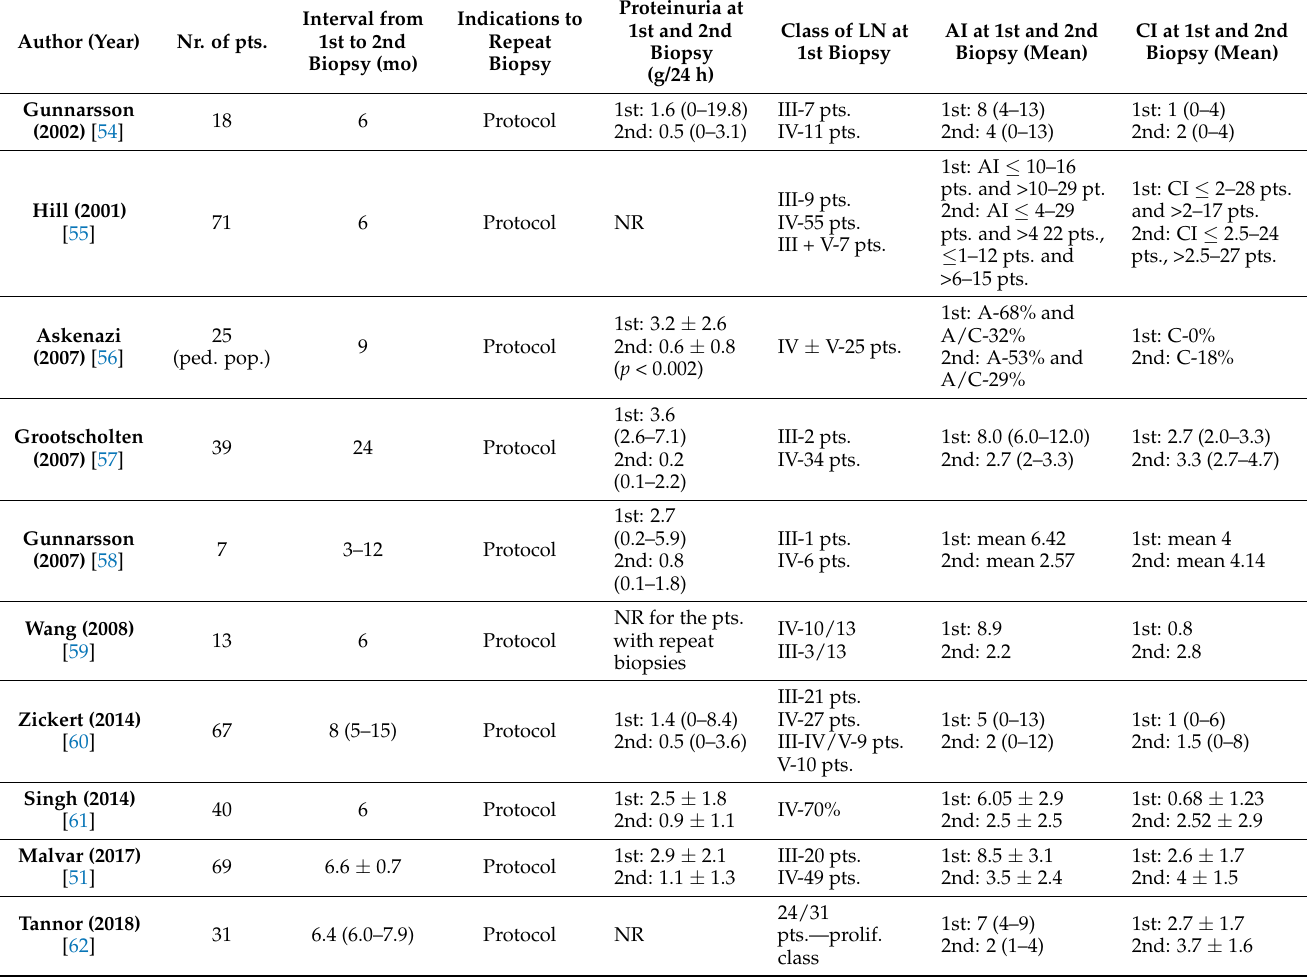
Table 4. Studies evaluating the role of repeat kidney biopsy in LN post-induction